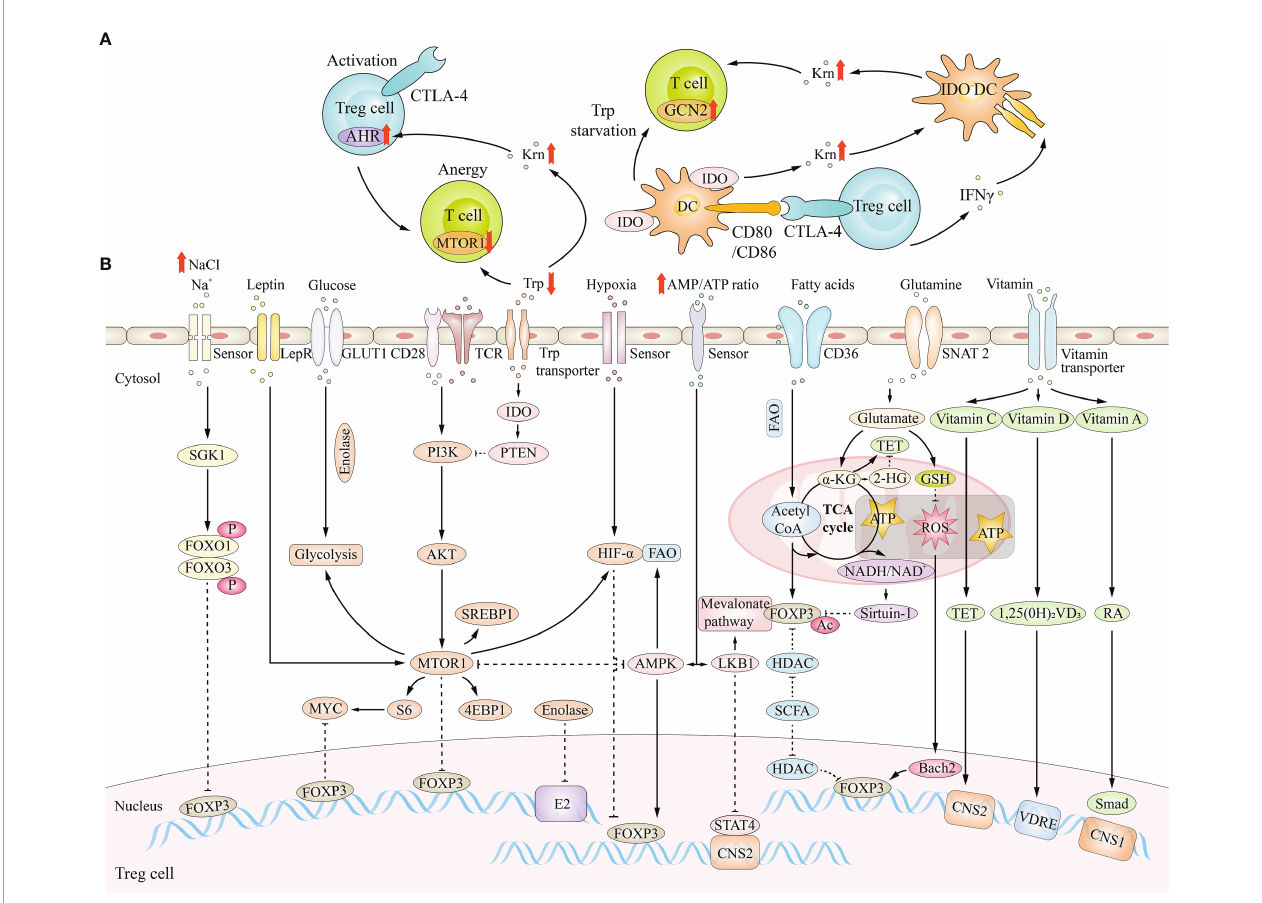
FIGURE 4 | Metabolic regulation in Treg cells. (A) Regulatory T cells have a crucial role in establishing an IFN- g -rich environment that activates Indoleamine 2, 3- dioxygenase (IDO)- and IDO+ dendritic cells (DCs), either by forward signaling to DCs or by direct production of the cytokine. (B) Cell-intrinsic metabolic programs and environmental factors that can modulate FOXP3 expression ultimately affect Treg cells